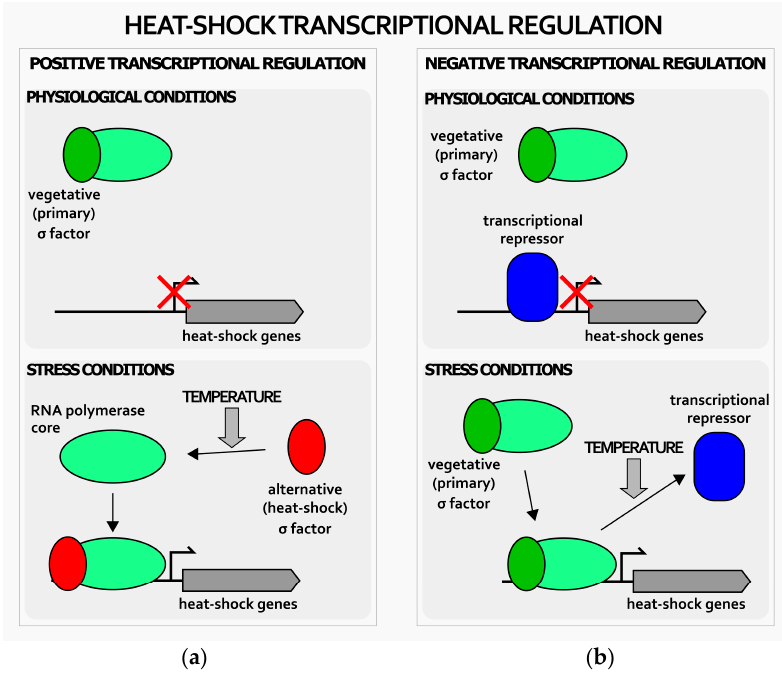
Figure 1. Schematic representation of positive and negative mechanisms of heat-shock genes transcriptional regulation in bacteria. Positive transcriptional regulation ( a ) relies on heat-shock alternative sigma factor (red oval) that, upon interaction with the core RNA polymerase (green oval), directs the transcription enzyme on heat-shock genes’ promoters, thereby activating their transcription; negative regulation ( b ) is based on repressors (blue oval) that keep transcription of heat-shock genes repressed during normal growth conditions. Upon heat-shock, they detach from heat-shock genes’ promoters, whose transcription is operated by the RNA polymerase associated to the primary σ factor (green oval). Bent arrow indicates the transcription start site.